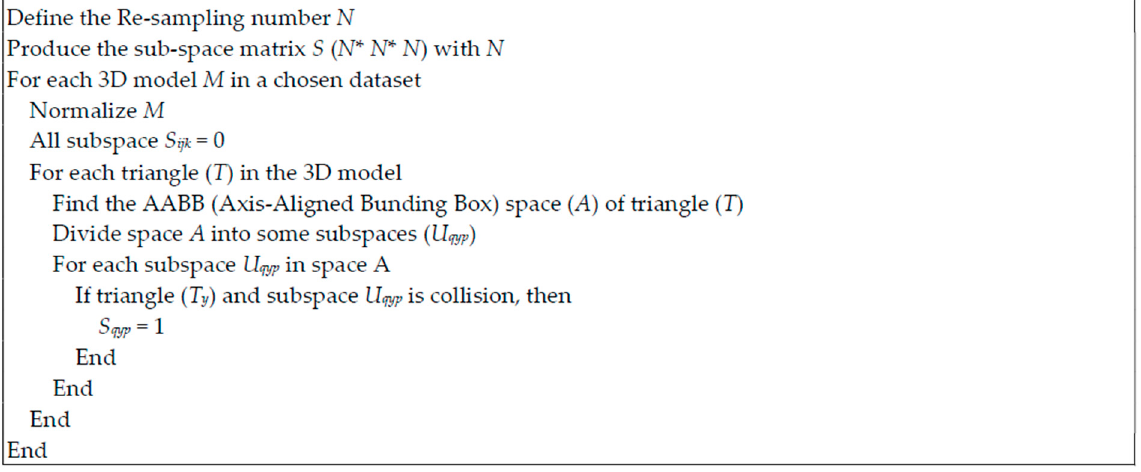
Figure 2. The pseudo code of CSS.